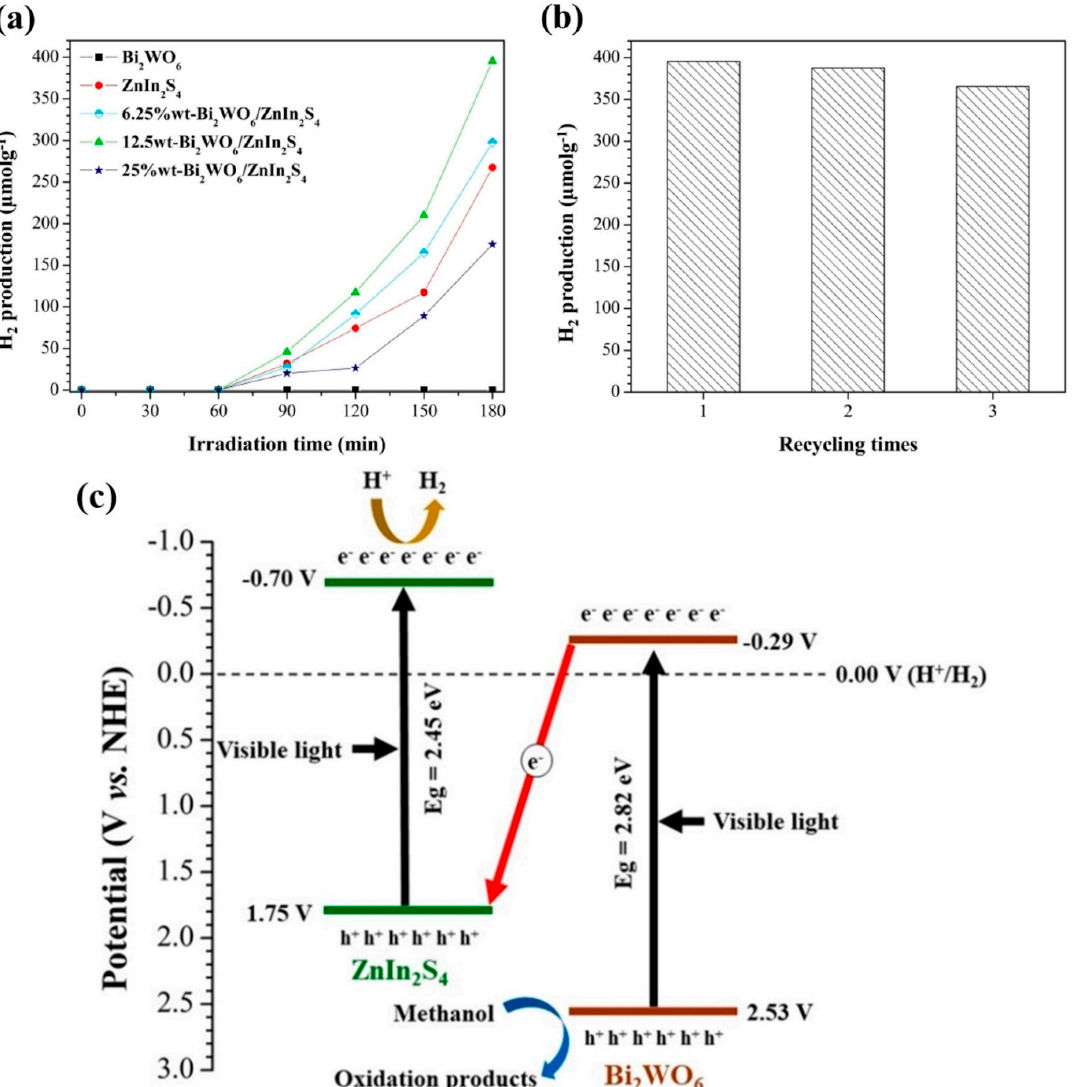
Figure 6. ( a ) Photocatalytic H 2 production of Bi 2 WO 6 /ZnIn 2 S 4 with different amount of Bi 2 WO 6 in comparison with the Bi 2 WO 6 and ZnIn 2 S 4 photocatalysts, ( b ) Cyclic H 2 production on 12.5%wt Bi 2 WO 6 /ZnIn 2 S 4 , and ( c ) Charge transfer mechanism for H 2 production by Bi 2 WO 6 /ZnIn 2 S 4 hetero- junction. [Reprinted with permission from reference [34]. Copyright 2021, Elsevier].